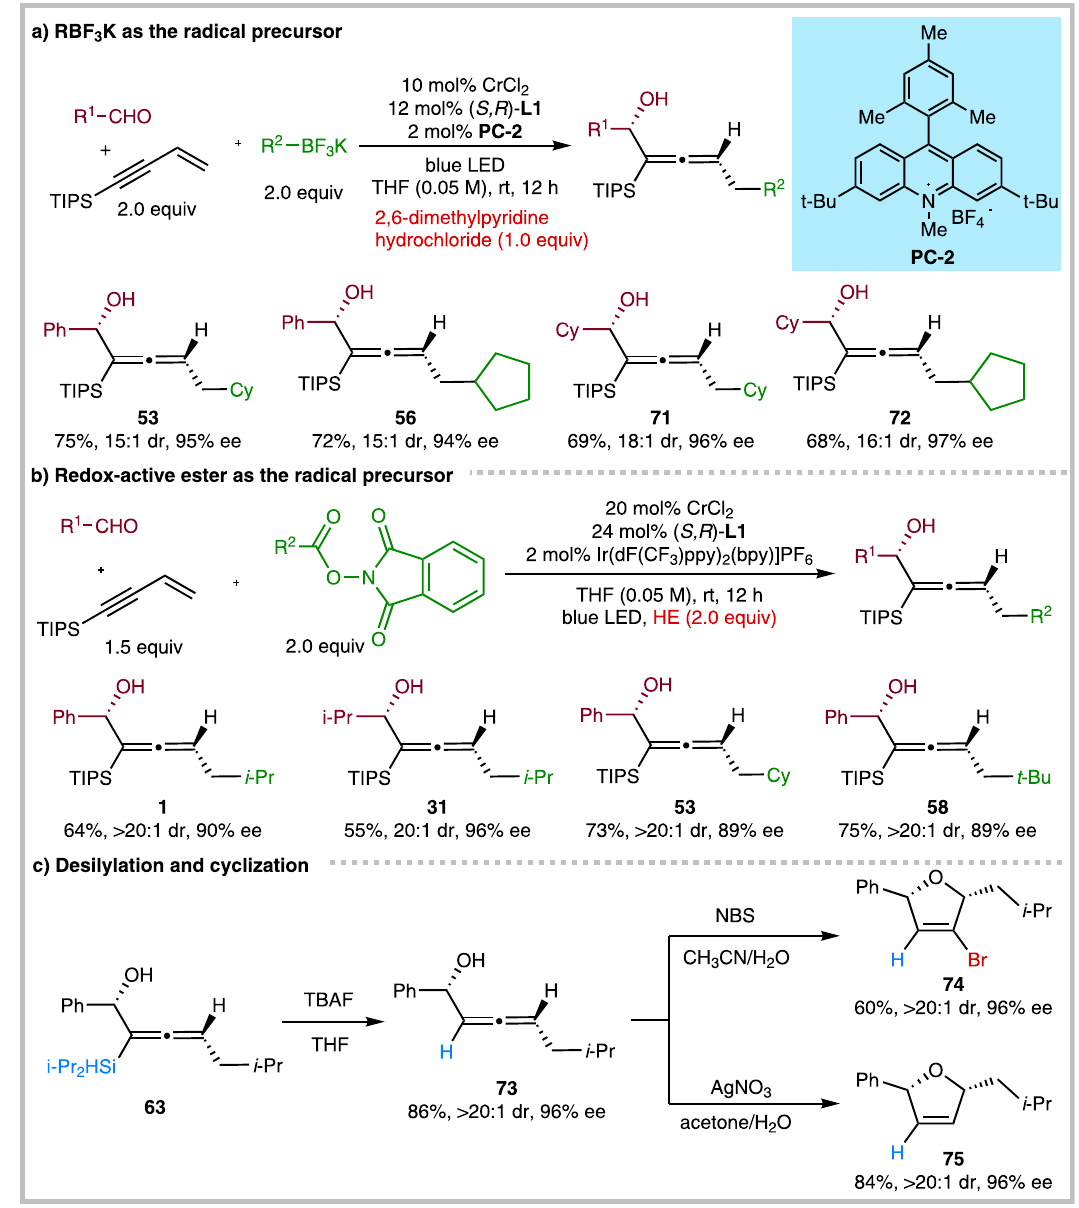
Fig. 5 | Exploration of other radical precursors and representative synthetic applications. a RBF 3 K as the radical precursor. b Redox-active ester as the radical precusor. c Desilylation and cyclization. NBS N